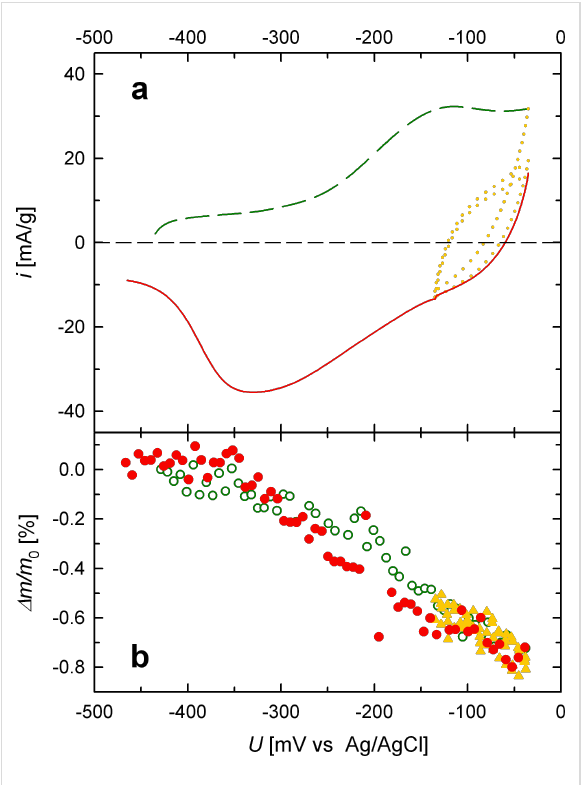
Figure 3: Relative variation of magnetic moment ( Δ m / m 0 , b) of porous nanocrystalline Pt upon electrochemical oxidation ( − 435 mV to − 35 mV, green: dashed line, open circles), electrochemical cycling between − 135 mV and − 35 mV (yellow: dotted line, full triangles), and electrochemical reduction ( − 35 mV to − 465 mV, red: solid line, full circles). (a) CV measured in situ at the identical sample (Pt SQUID ). Measurements performed in 1 M KOH at 5